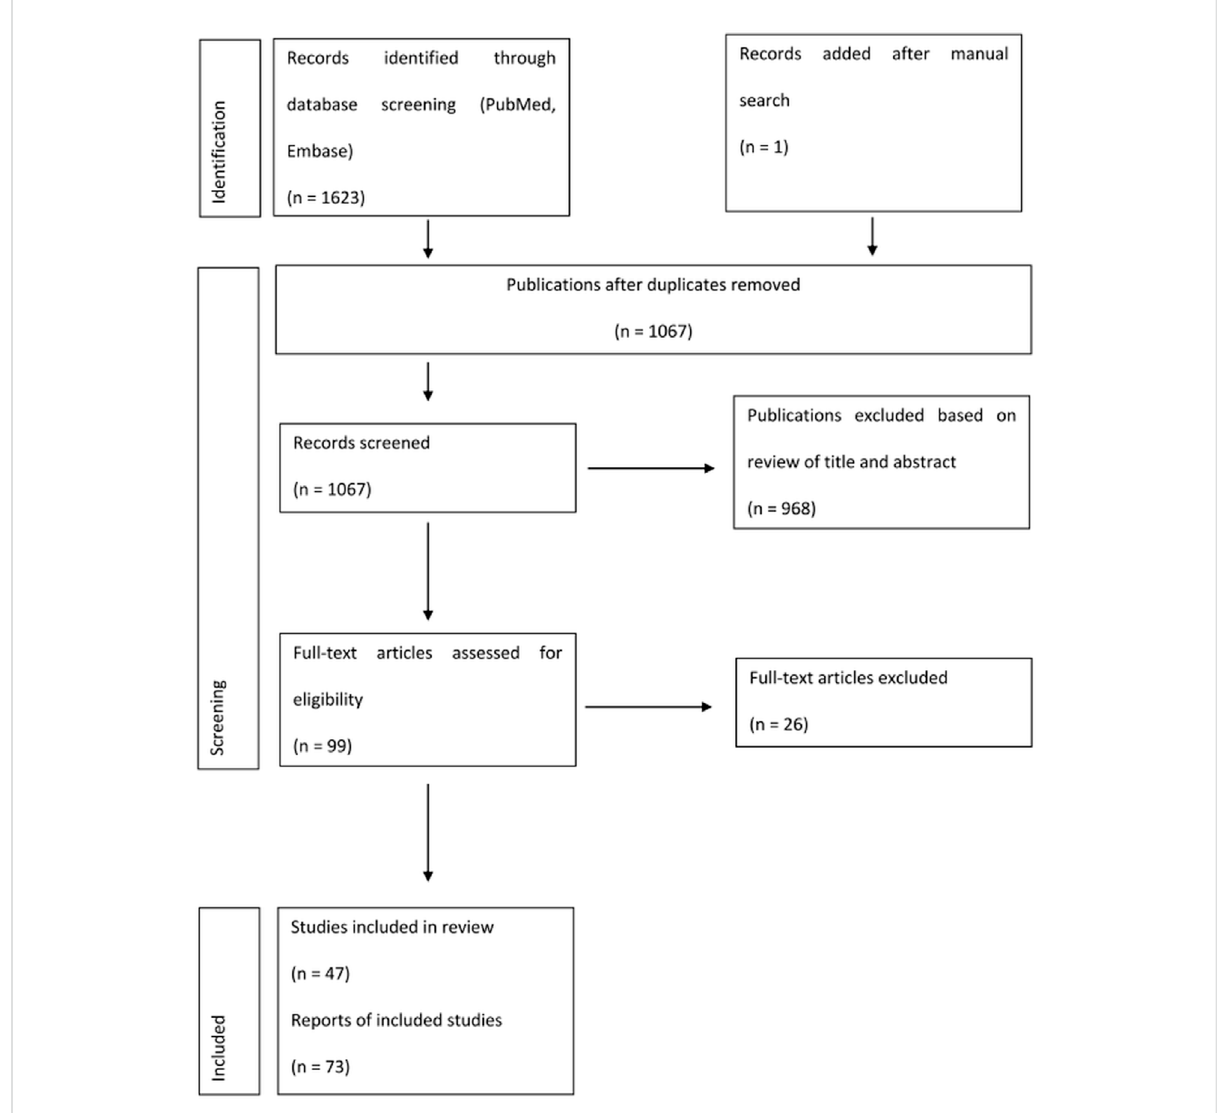
FIGURE 1 Flow diagram for selection of studies included in the systematic review and